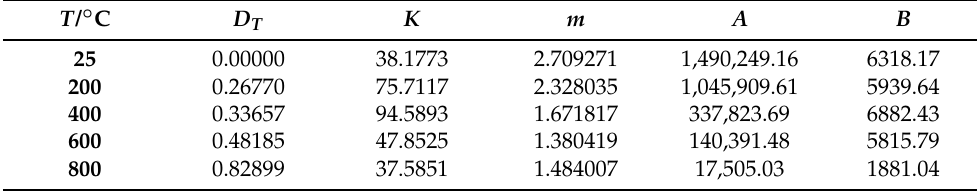
Table 2. Parameters of the constitutive model of thermally damage